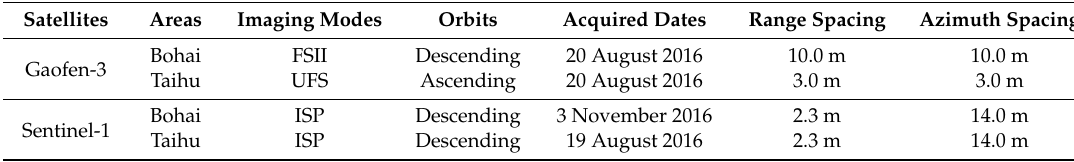
Table 2. Basic information of the used